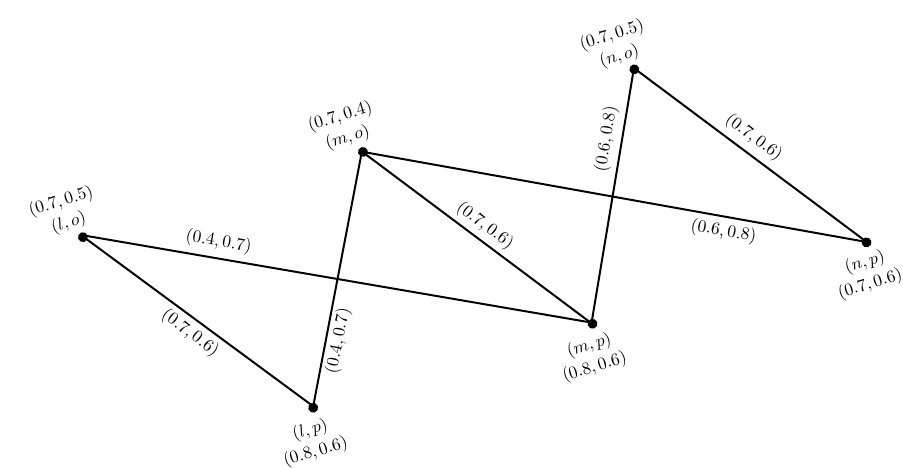
Figure 6. Semi-strong product of two